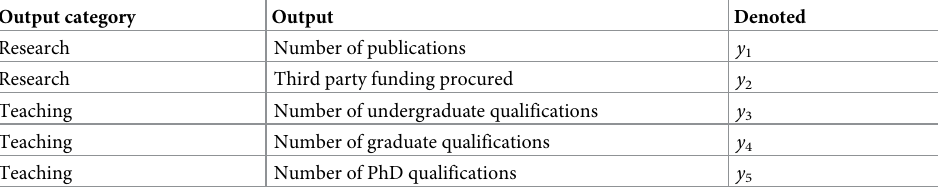
Table 1. Dimensions of output and the variables used to operationalize the dimensions.